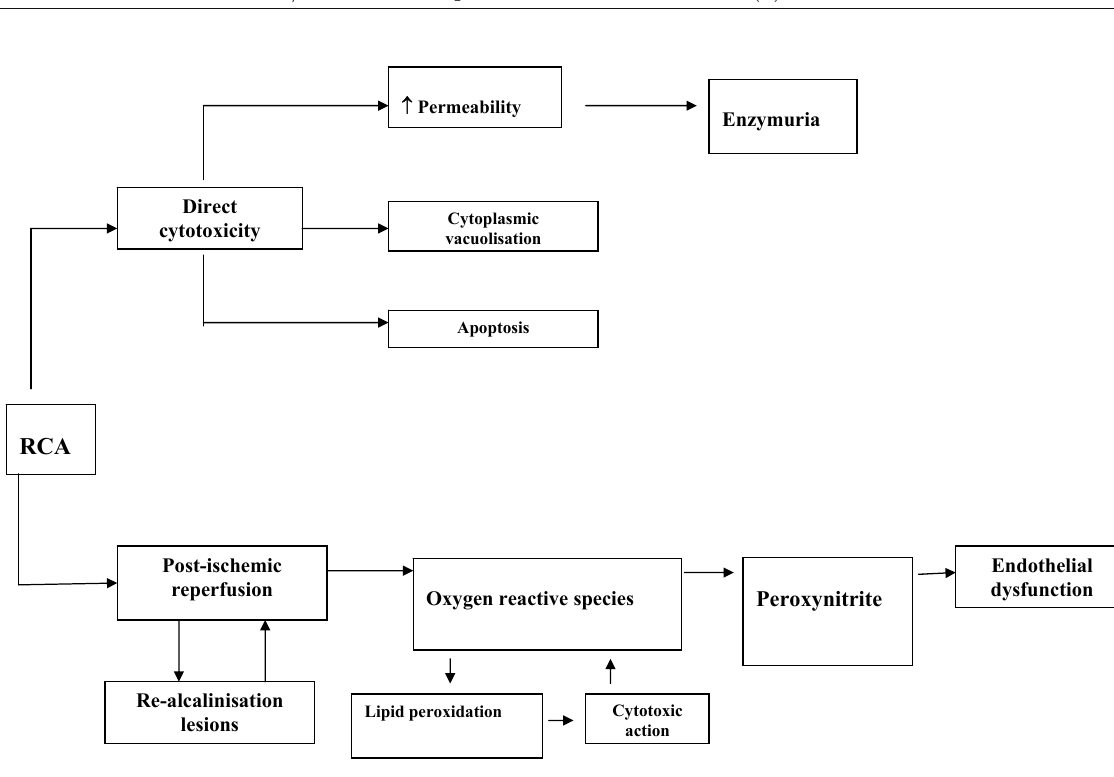
Fig. 1 Pathogenesis of radiocontrast-induced nephropathy. RCA = radiocontrast